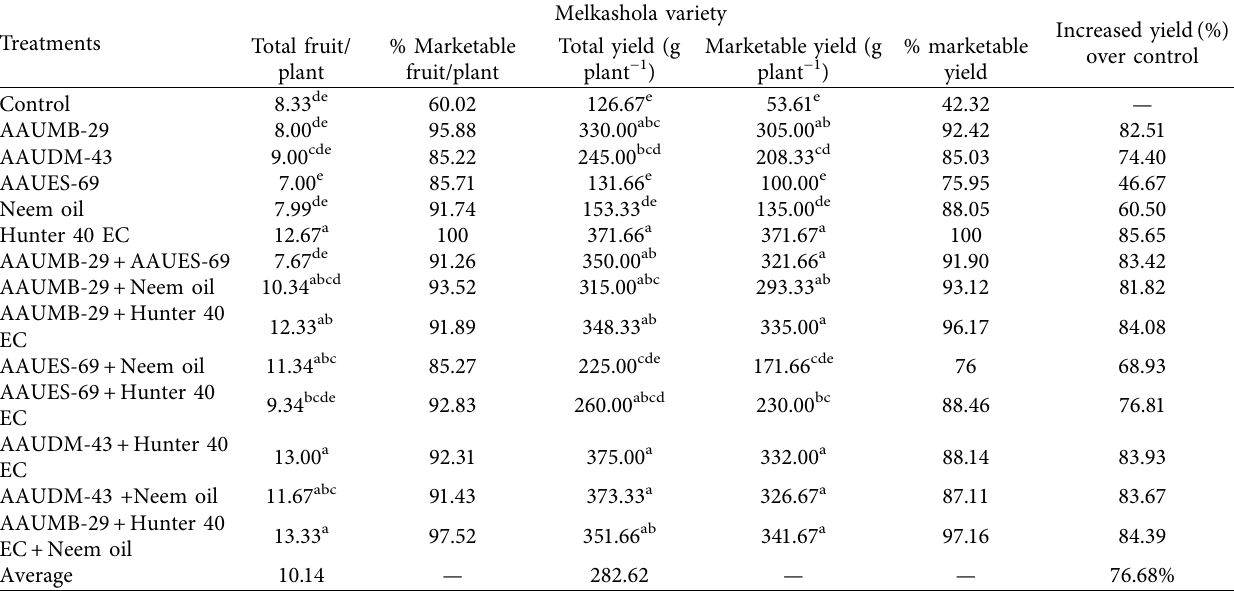
Table 6: The effects of treatments on the fruit yield of the Melkashola tomato variety under greenhouse condition. Treatments